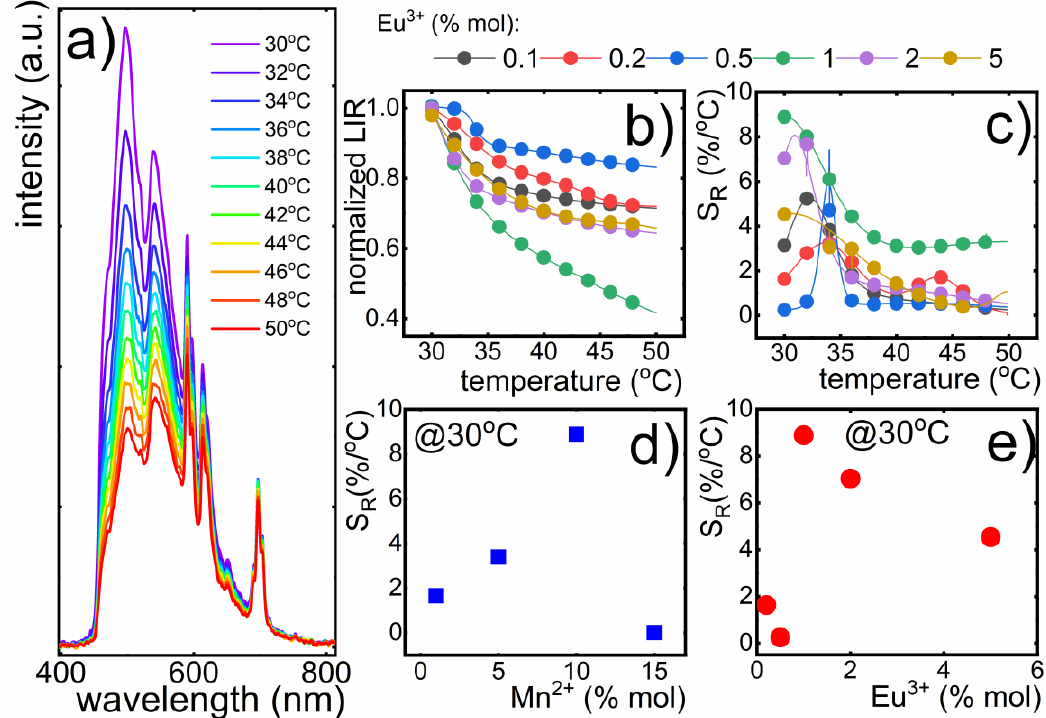
Figure 4. Thermal evolution of the emission spectra of GdPO 4: 1%Eu 3+ , 10%Mn 2+ nanoparticles ( a ); LIR ( b ) and S R ( c ) as a function of temperature for different Eu 3+ concentration; the maximal values of S R for different concentration of Mn 2+ (1, 5, 10, 15%) with 1% Eu 3+ ions ( d ) and Eu 3+ (0.1, 0.2, 0.5, 1, 2, 5%) with 10% Mn 2+ ions ( e ). Table 1. Comparison of the parameters for different manganese-based luminescent thermometers.